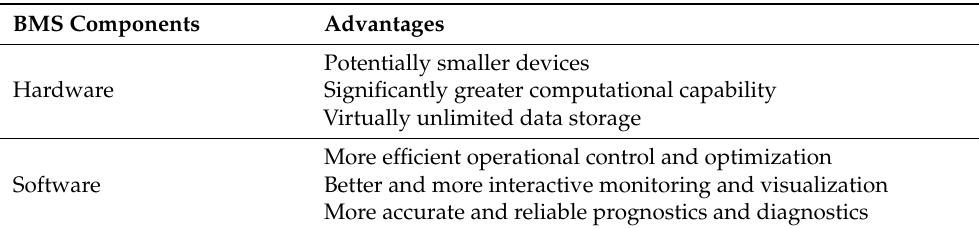
Table 1. Advantages of the cloud-based smart